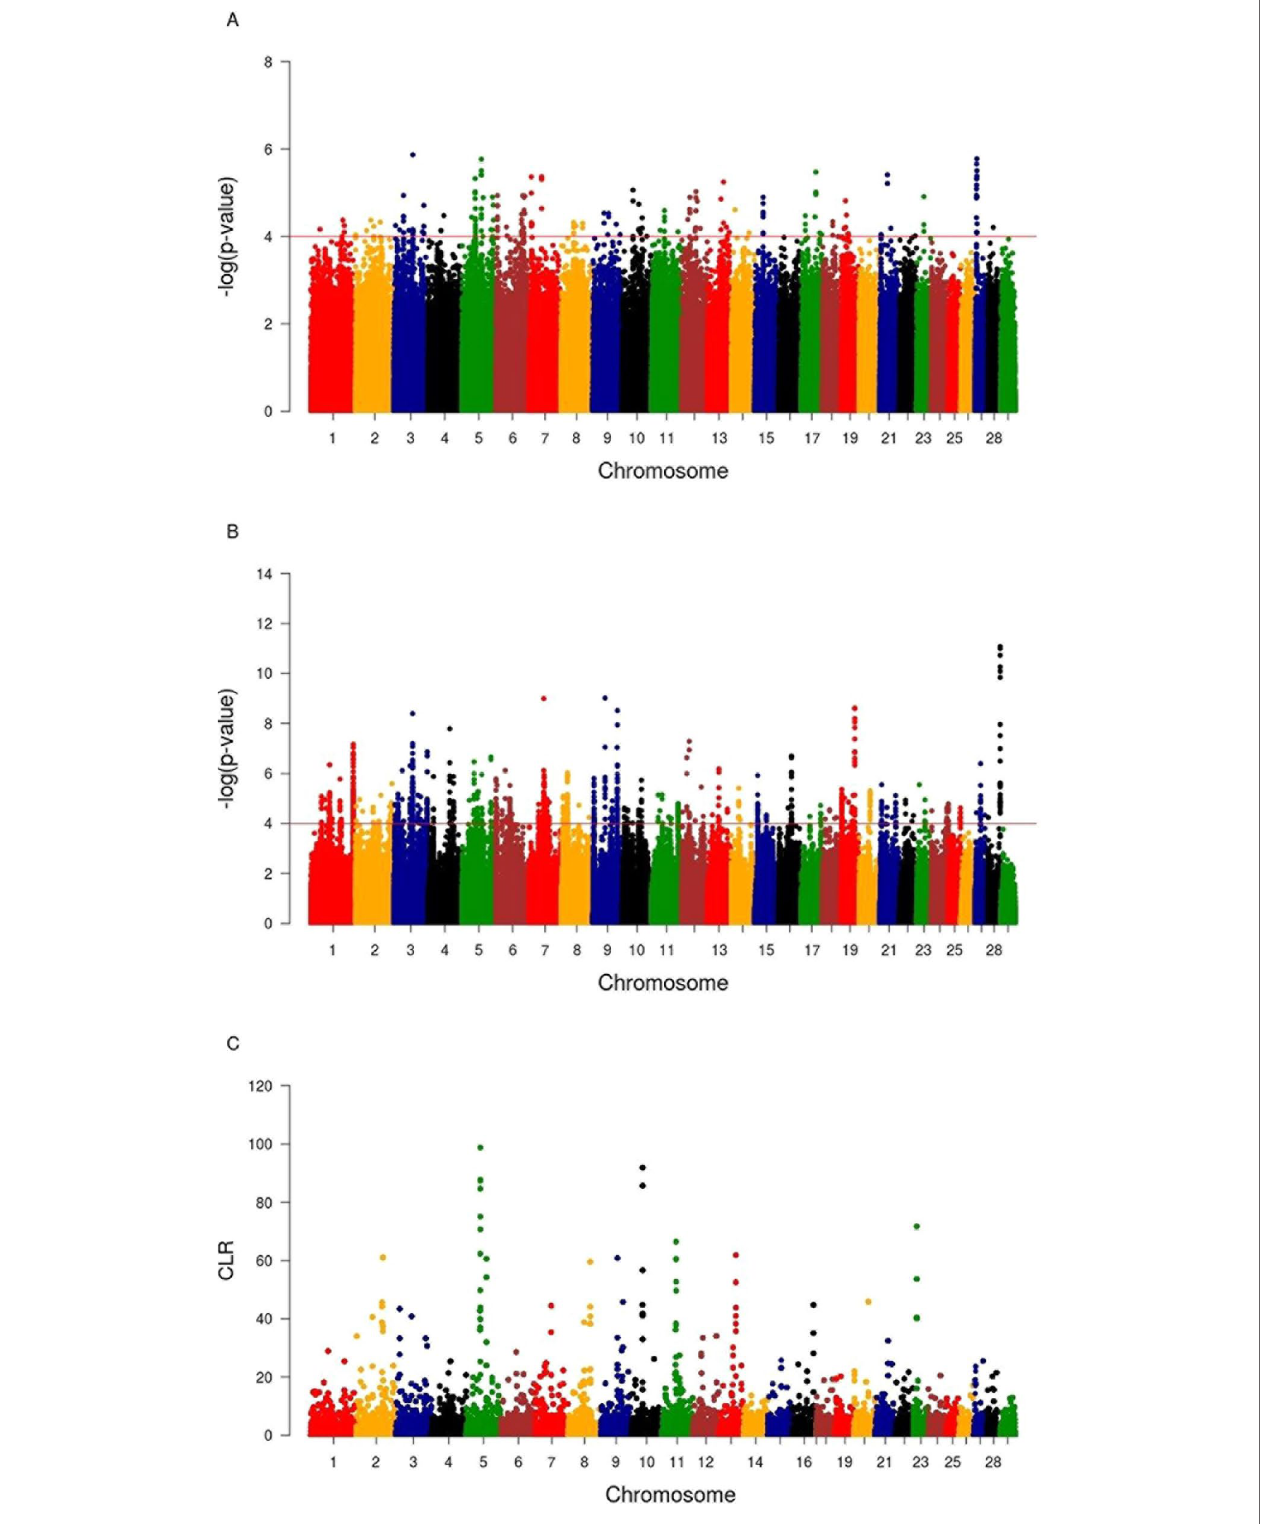
FIGURe 4 | Manhattan plots of genome-wide iHS (A) , Rsb (B) , and CLR (C) analyses. The x-axis shows the autosomal chromosomes and the y-axis shows −log transformed P -values (A and B) and CLR values (C) .